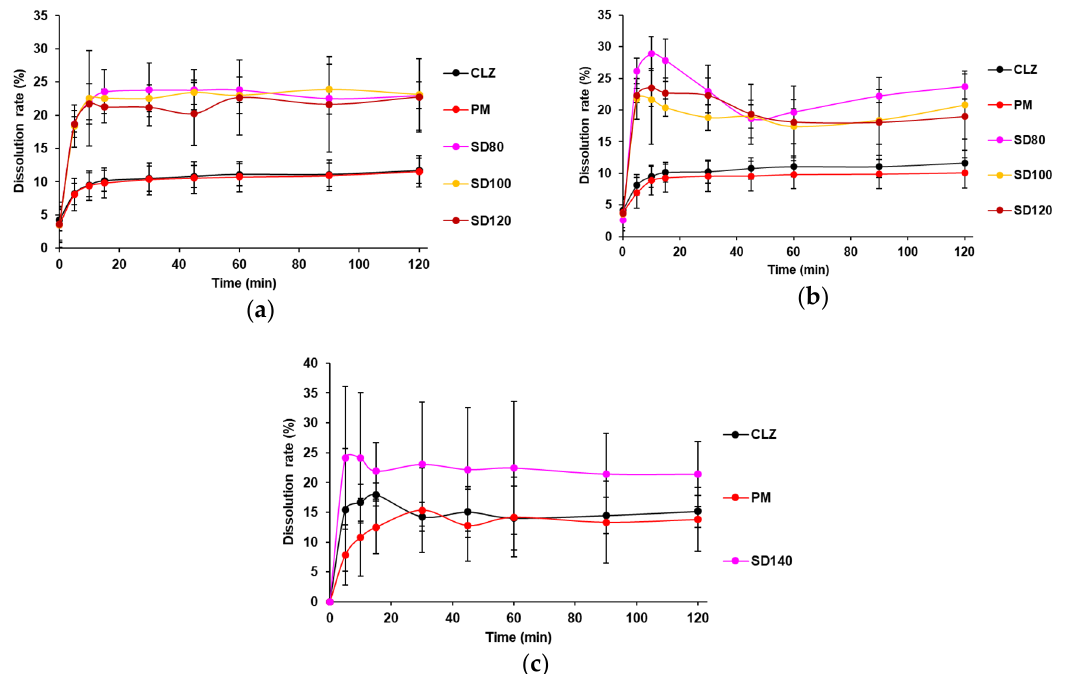
Figure 7. Dissolution behavior of CLZ-cocrystals. ( a ) CLZ-4HBA cocrystals, ( b ) CLZ-2,4DHBA cocrystals, and ( c ) CLZ-2,5DHBA cocrystals. Data are presented as the mean ± standard deviation (n = 3).